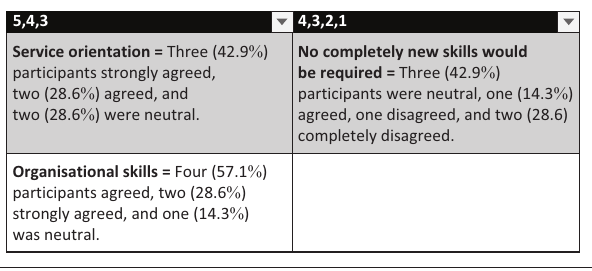
FIGURE 5: Results of organisation operation skills with no consensus.